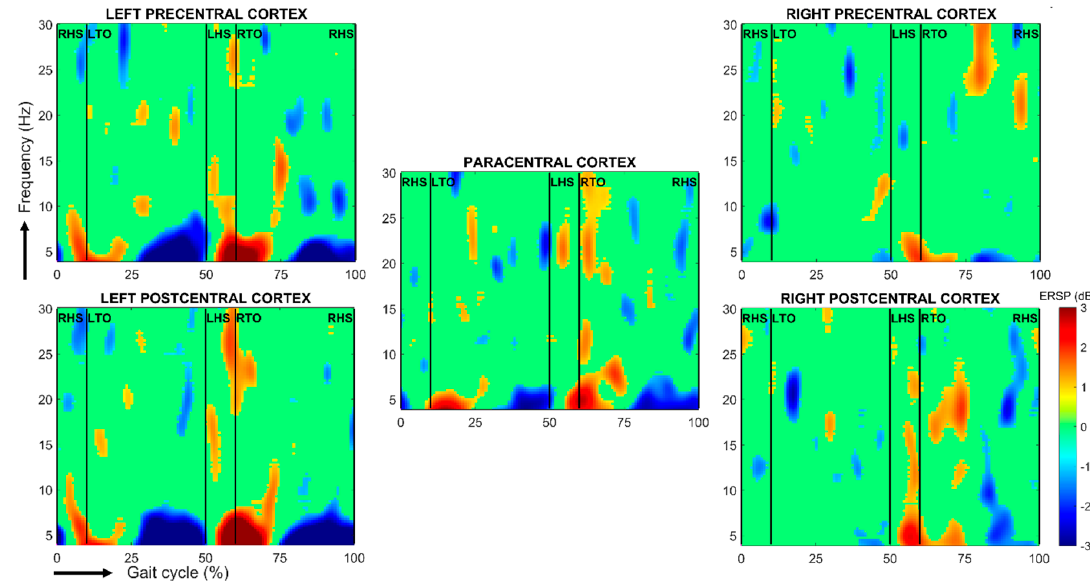
Figure 4. Spectral perturbations related to right heel-strike during a stride cycle relative to the full gait cycle baseline over the left and right pre-, para- and postcentral cortices. The subject performed 52 gait cycles on a treadmill. Using BRAINTSTORM toolbox [61], the head model was created from a standard MRI template and the boundary element method was used for calculating the leadfield matrix, whereas cortical sources were reconstructed thanks to weighted minimum-norm estimates before projecting the obtained dipole sources on 68 cortical regions from the Desikan-Killiany atlas. The single-trial spectrograms were linearly time-warped in order to adjust the latencies of right heel-strikes in each epoch and thus to align gait cycles. Finally, a bootstrap test was performed, with alpha = 0.1. RHS/LHS: right/left heel-strike; RTO/LTO: right/left toe-off.